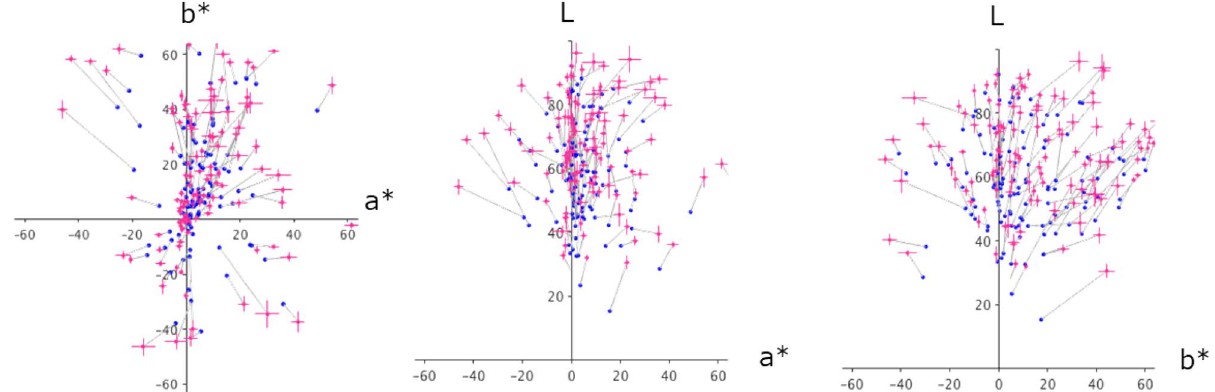
Figure 4. Distribution of matched representative colors in La * b * color space. The red circles represent the matched representative colors averaged across 10 observers, and the blue circles connected to it represent the pixel mean of the test image. Each panel shows the results in the a * –b * , a * –L, and b * –L planes. Error bars represent the ± 1 s.e.m. across observers.